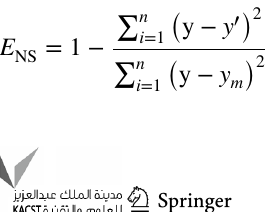
Fig. 4 Performance of GPR model: a predicted TDS for each sam- pling points in GW; b predicted vs observed TDS in GW; c predicted TDS for each sampling points in SW; d predicted vs observed TDS in